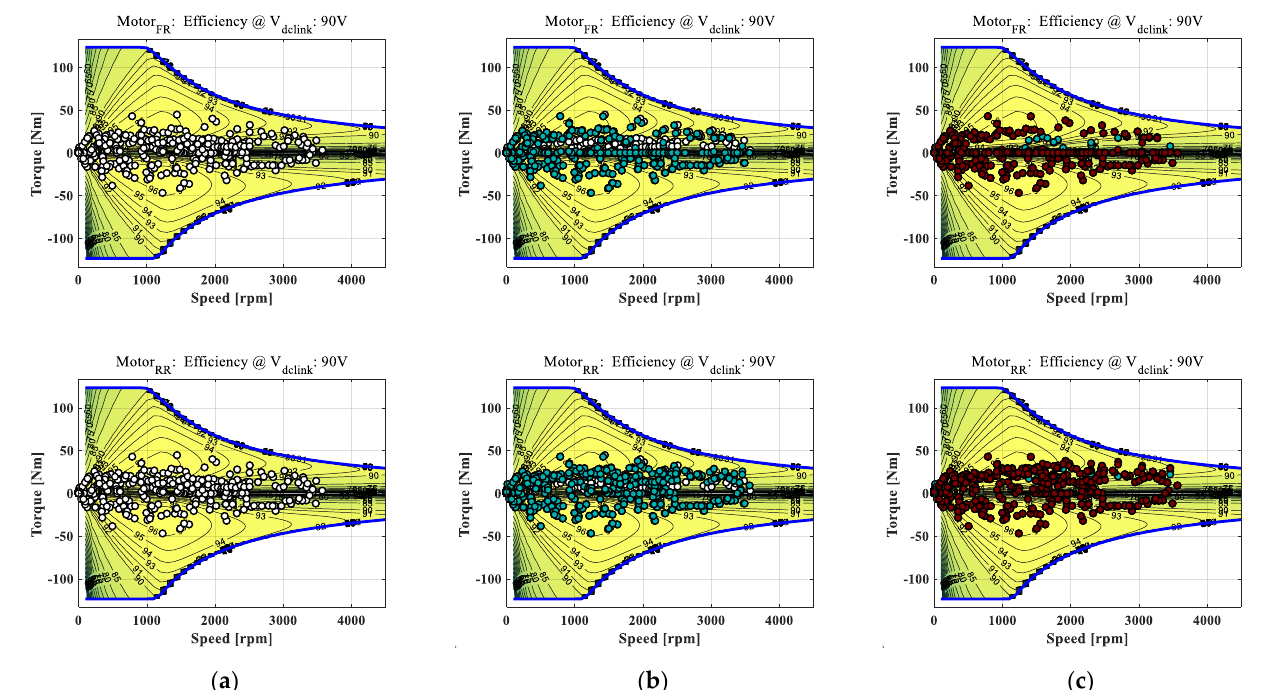
Figure 15. Operating points: ( a ) Uniform distribution, ( b ) Optimization@ V norm ( 90 V ) , and ( c ) Optimization@ V dclink .